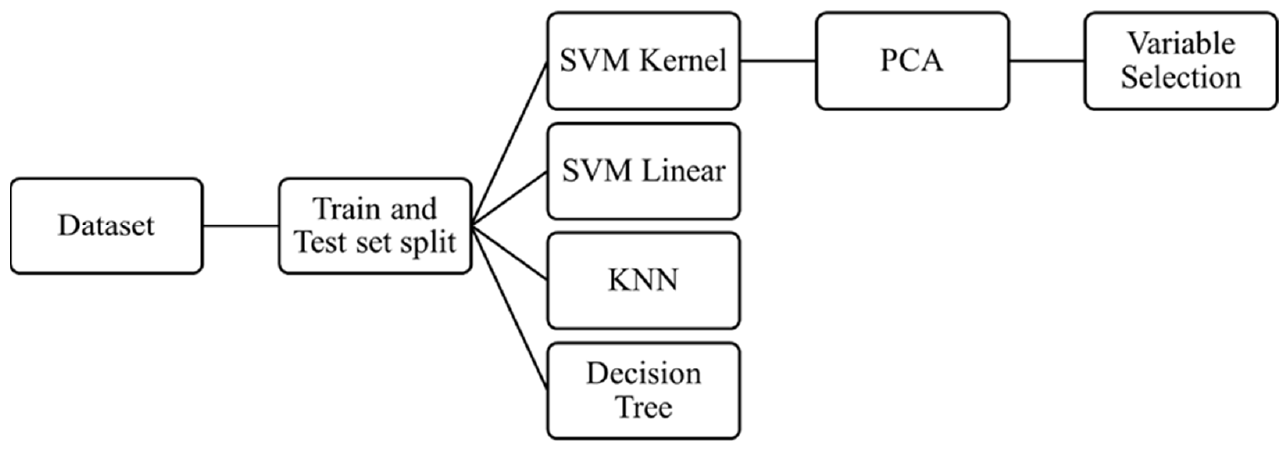
Figure 1. Flow diagram representing the methodology of machine learning and the classifier algo- rithms used. SVM = supervised machine learning, KNN = k-nearest neighbor, PCA = principal com- ponent analysis.